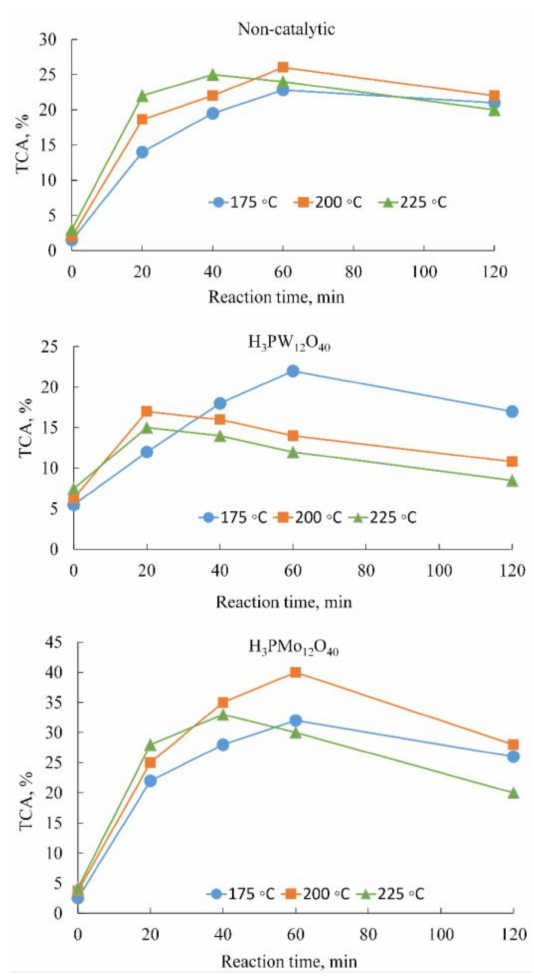
Figure 1. Effect of temperature and reaction time on the total carboxylic acids (TCA) yield. In the catalytic experiments, the lignin:catalyst ratio was 2:1 ( w / w